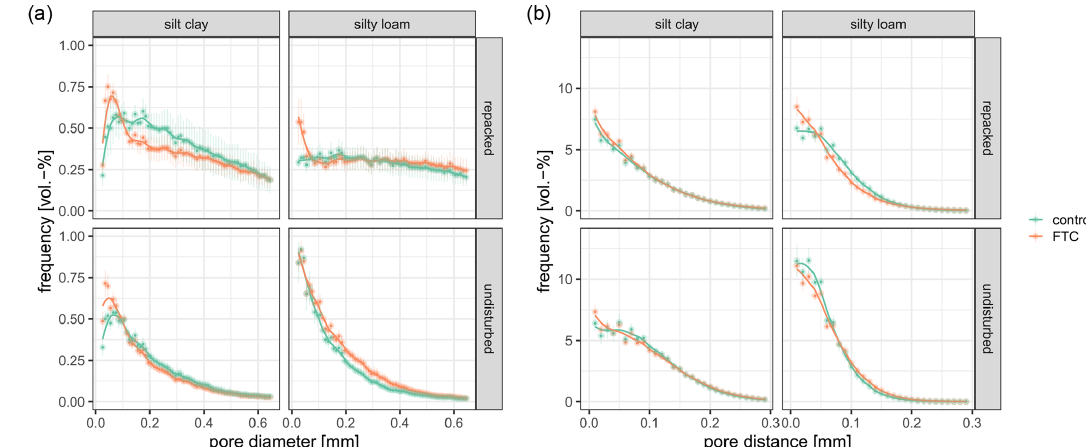
Figure 4. The mean pore size distribution (a) and the mean pore distance distribution (b) determined at a resolution of 10µm. The point ranges mark the 95% confidence interval of the represented data (2 standard errors). Data from the control are shown in green, and data obtained from subsamples taken after 19 FTCs are shown in